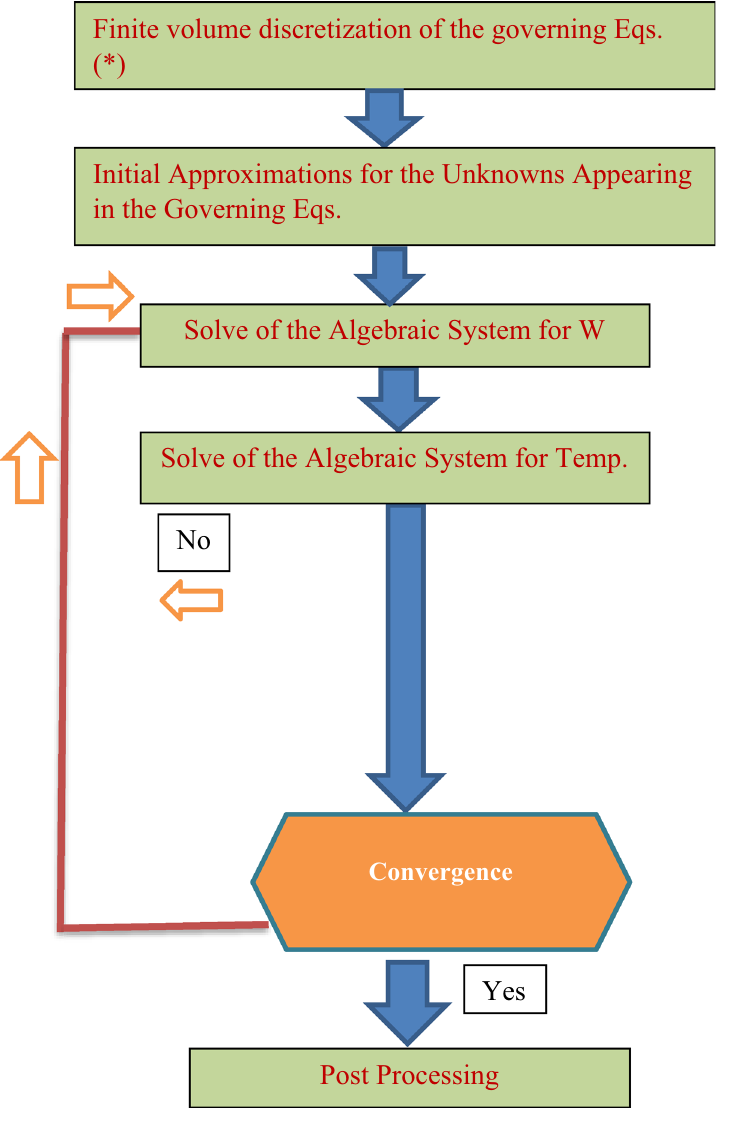
Figure 3. Flow Chart for the Numerical